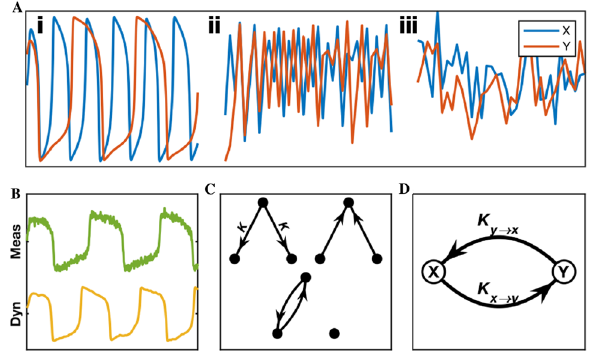
Figure 1. Simulated Data. ( A ) Time series from the three classes of model used for validation: (i) Van der Pol Oscillators, (ii) Logistic Maps, (iii) Autoregressive Models. ( B ) Trace of a VDP with measurement noise (top) and (Bottom) dynamic noise. ( C ) Types of causal networks used to generate trials for assessing detection accuracy. Three variable networks afford the ability to test a method’s performance in the presence of third party confounds such as the common driver of two uncoupled variables in (Top Left). All other three variable topologies had to be omitted because they contain transitive causal relationships which leads to ambiguous pairwise results. In each network the coupling strength, K , of both edges is the same. ( D ) Two variable networks used to test the response to coupling parameters. K x → y and K y → x can vary